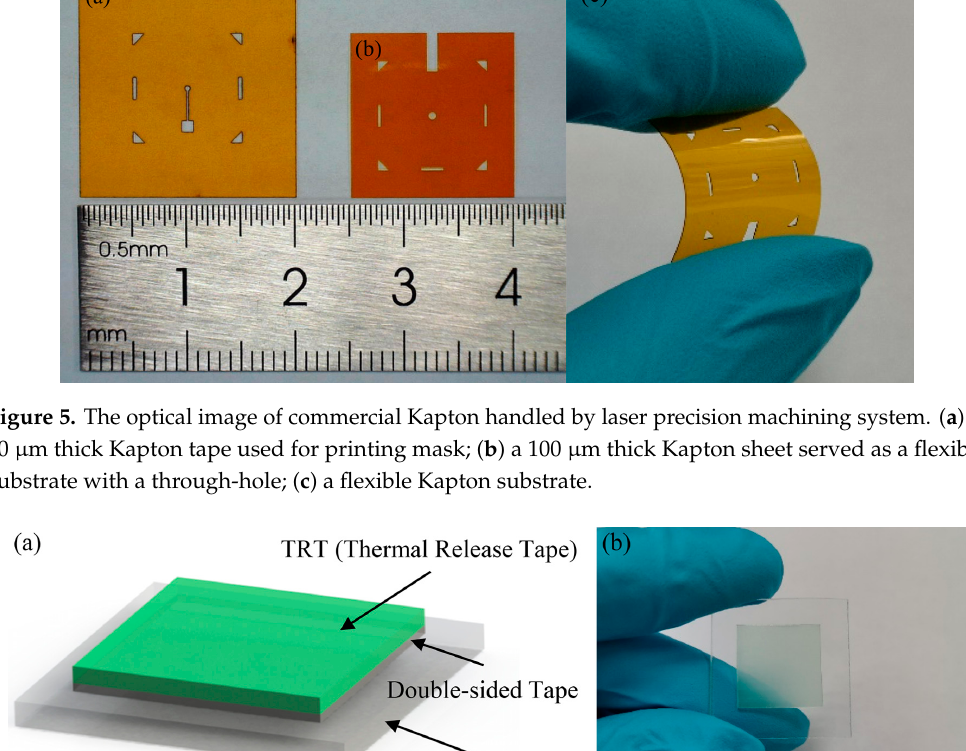
Table 2. Laser parameters used for ablating the pattern.